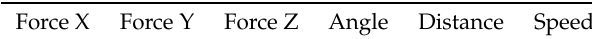
Table 10. REMOVI to PC data frame.